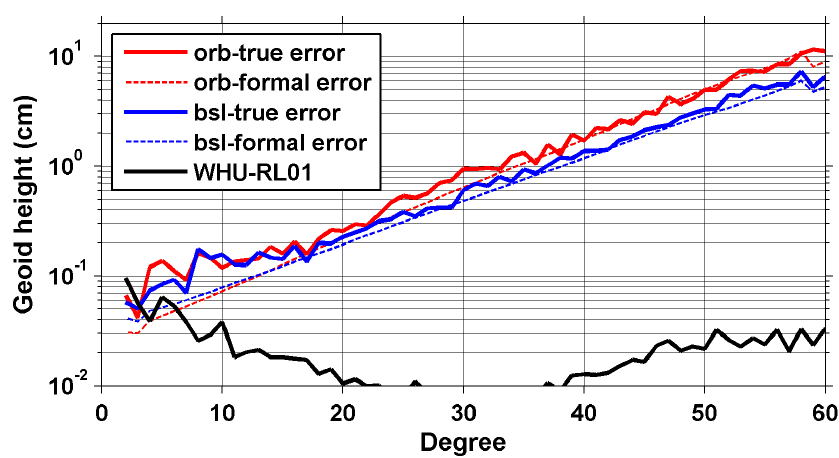
Figure 2. Geoid height errors per degree for different gravity field solutions in January 2010.